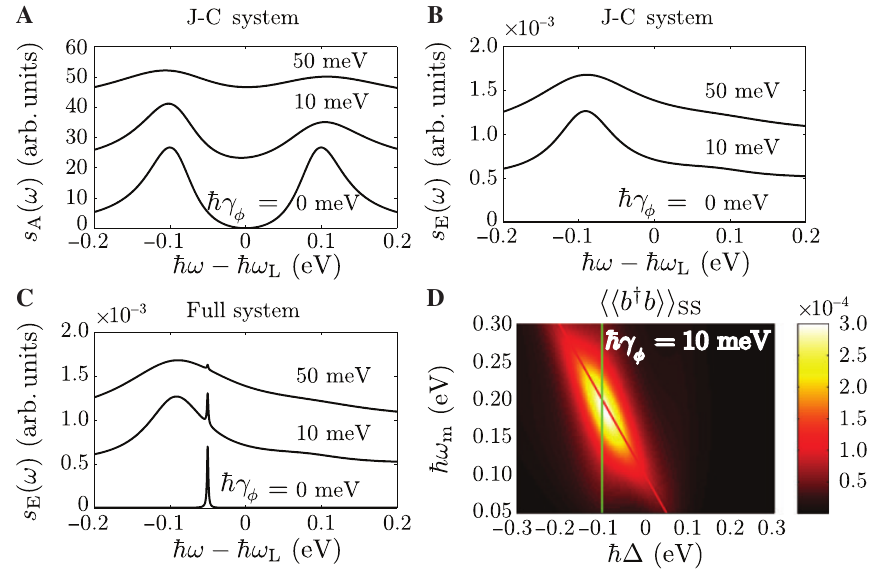
Figure 5: Effect of pure dephasing for weak illumination ( ħ ℰ = 1 meV) and electron–vibration coupling d = 0.1. (A) Absorption spectra and (B) emission spectra for the simple J-C system in Figure 1, displayed for three different values of pure dephasing, = 0 meV, 10 meV, and 50 meV, pumped by monochromatic illumination tuned to the plasmonic resonance ħ Δ = ħ ω ħ γ φ spectra of the full molecule–plasmon system (sketched in Figure 2A) including the vibrational mode of frequency ħ ω and the same γ values as in (A, B). The spectra in (A–C) are offset from each other by a constant value of s φ (D) Incoherent populations of the vibrational mode as a function of detuning and vibrational frequency for pure dephasing ħ γ The lines drawn into the colour maps mark the detuning Δ for which the first-order Stokes line (red line) or the incident laser (green line) coincides with one of the bare J-C absorption peaks. The other parameters used for all the calculations in (A–D) are ħ γ = 150 meV, ħ g = 100 meV, ħ Δ = ħ δ = 0 ħ γ a